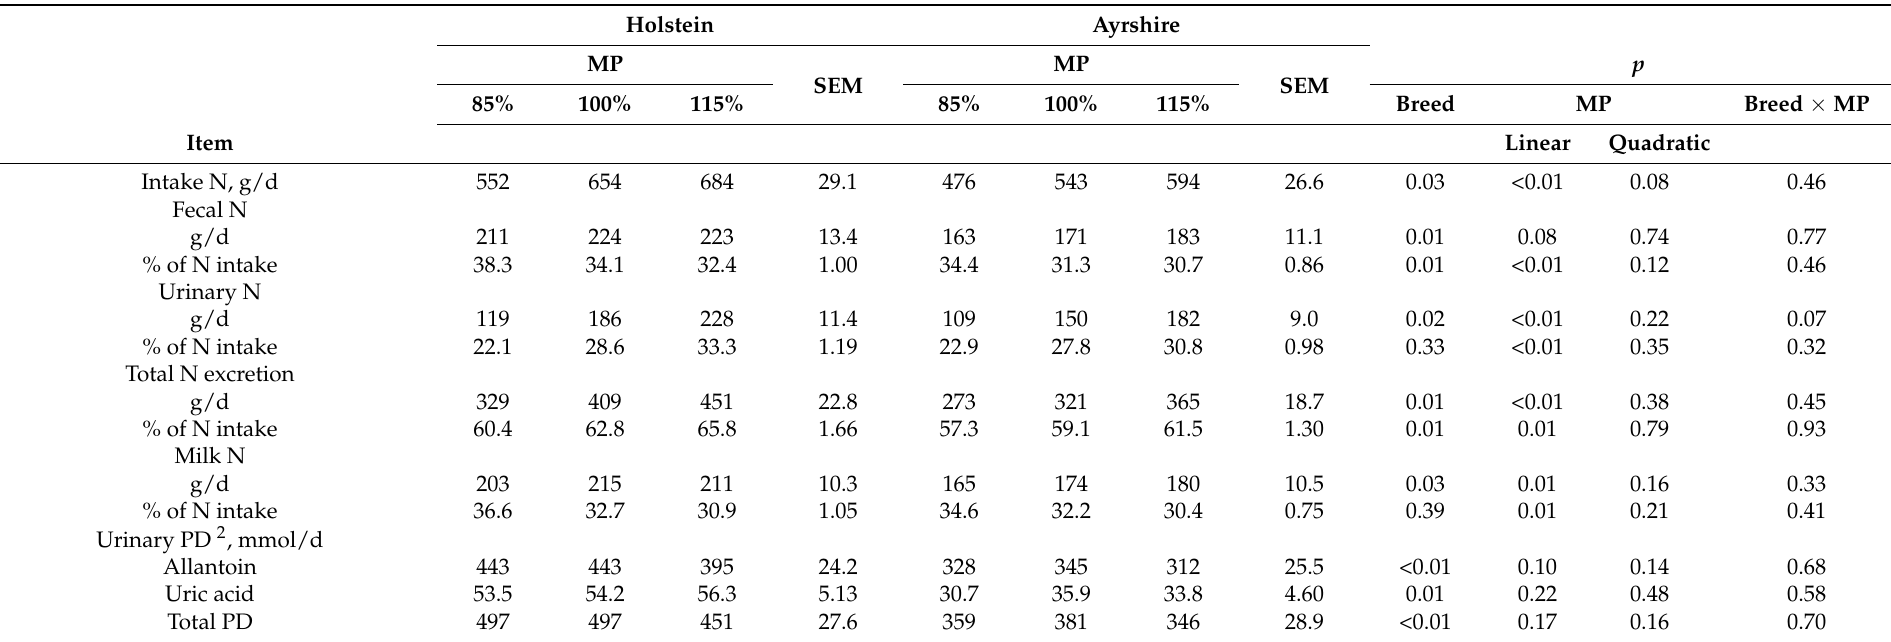
Table 8. Nitrogen utilization in lactating Holstein and Ayrshire cows fed diets formulated to provide 85%, 100%, or 115% of metabolizable protein (MP) requirement 1